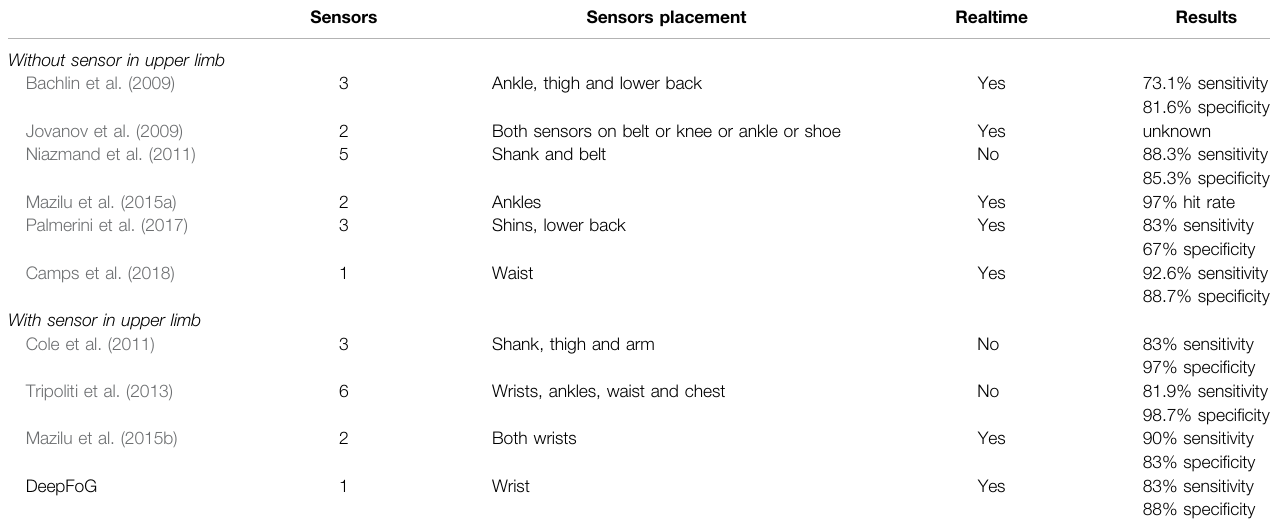
TABLE 1 | Comparison of the proposed single-wrist approach FoG detection with other studies exploiting one or more sensors to capture movement. Sensors Sensors